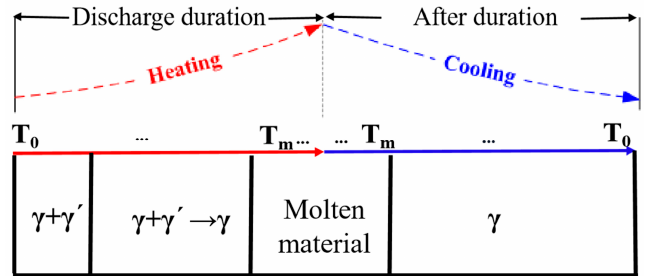
Figure 7. Schematic diagram of recast layer evolution of the fourth-generation single-crystal superalloy after EDM.